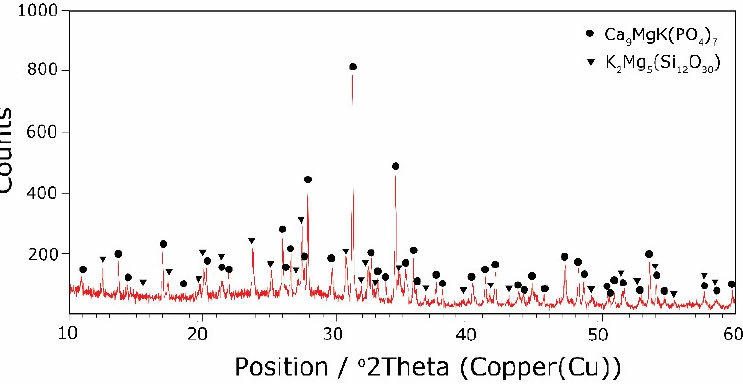
Figure 6. XRD patterns of 10B devitrificate obtained after isothermal heating at 798 °C (no 10B_798).